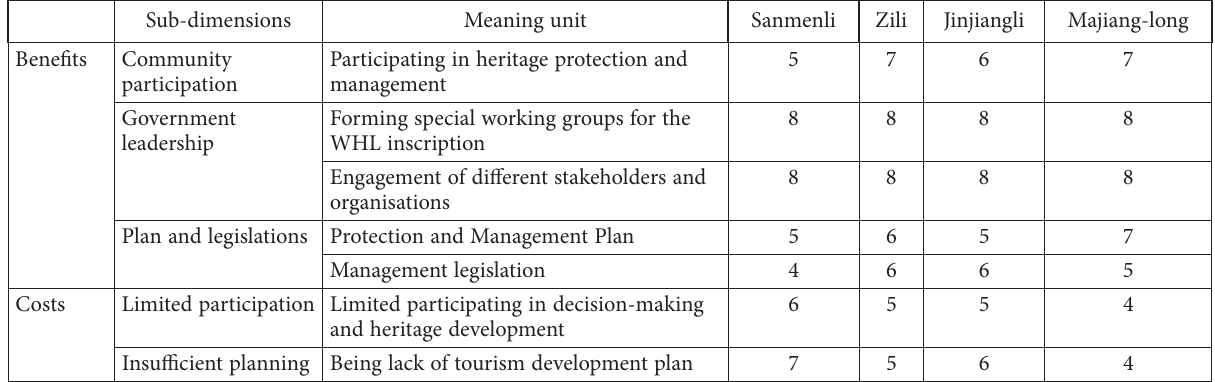
Table 8. Impacts of the WHL inscription from the political aspect (source: field survey)